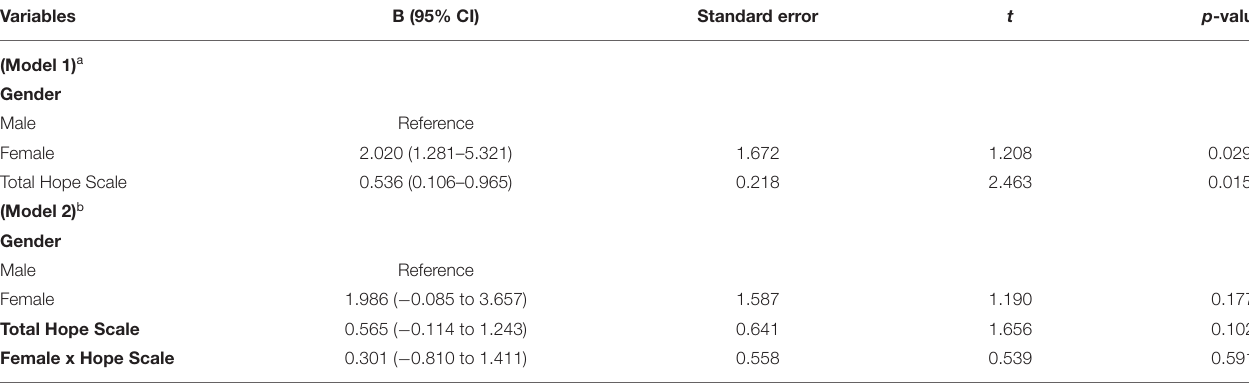
Total Hope Scale